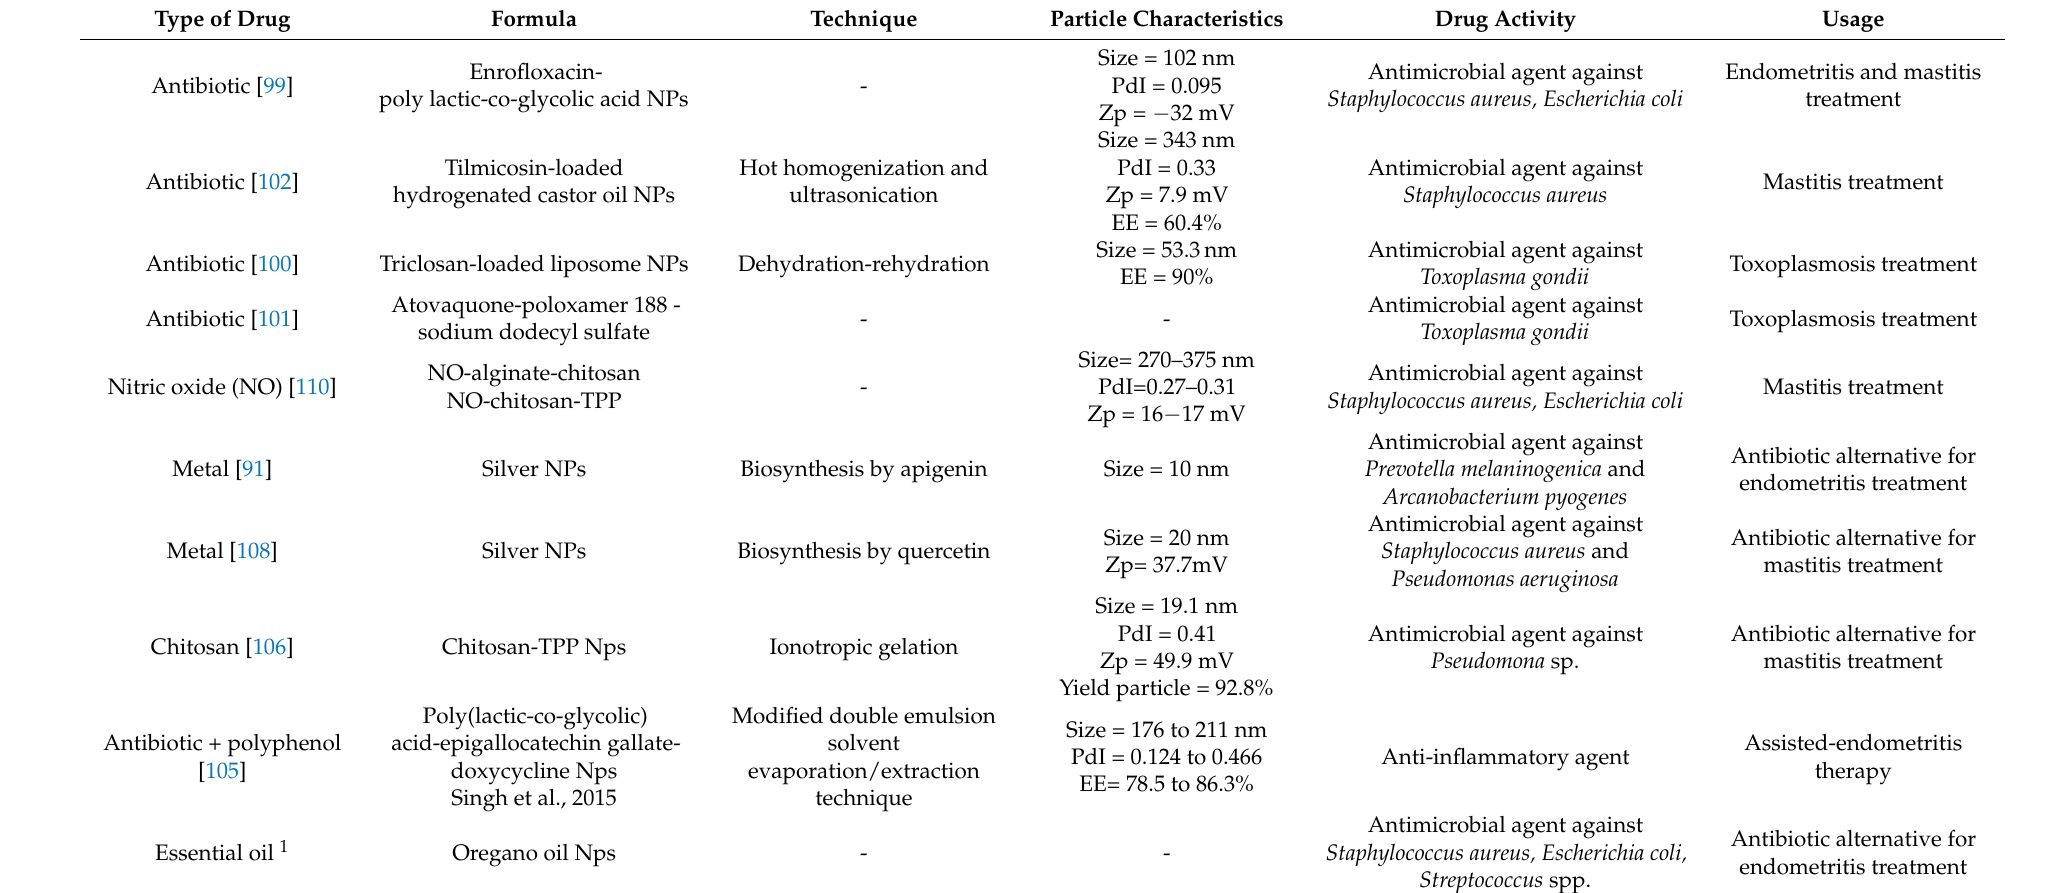
Table 3. Summary of studies on the nano drugs developed to treat reproductive-related